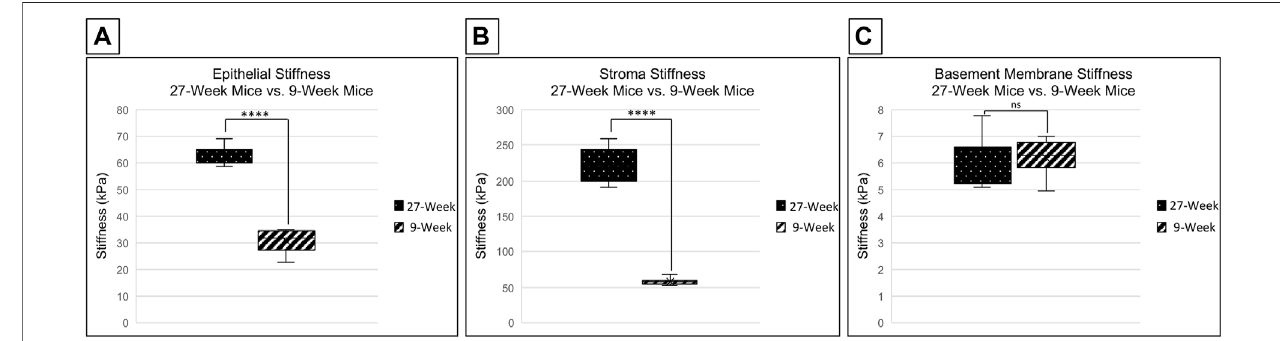
FIGURE 2 | Comparison of corneal stiffness between 9- and 27-week mice. Nanoindentation was performed to compare the stiffness of the corneal epithelium, stroma, and basement membrane between enucleated globes from 9- and 27-week mice. Signi fi cance was determined by a two-tailed Student ’ s t-test comparing